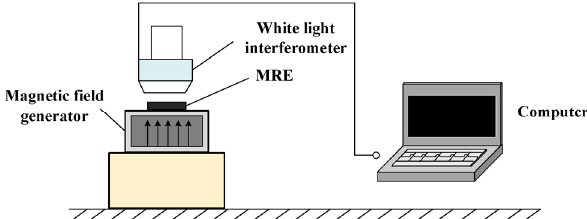
Fig. 11 Schematic of the white light interference experiment